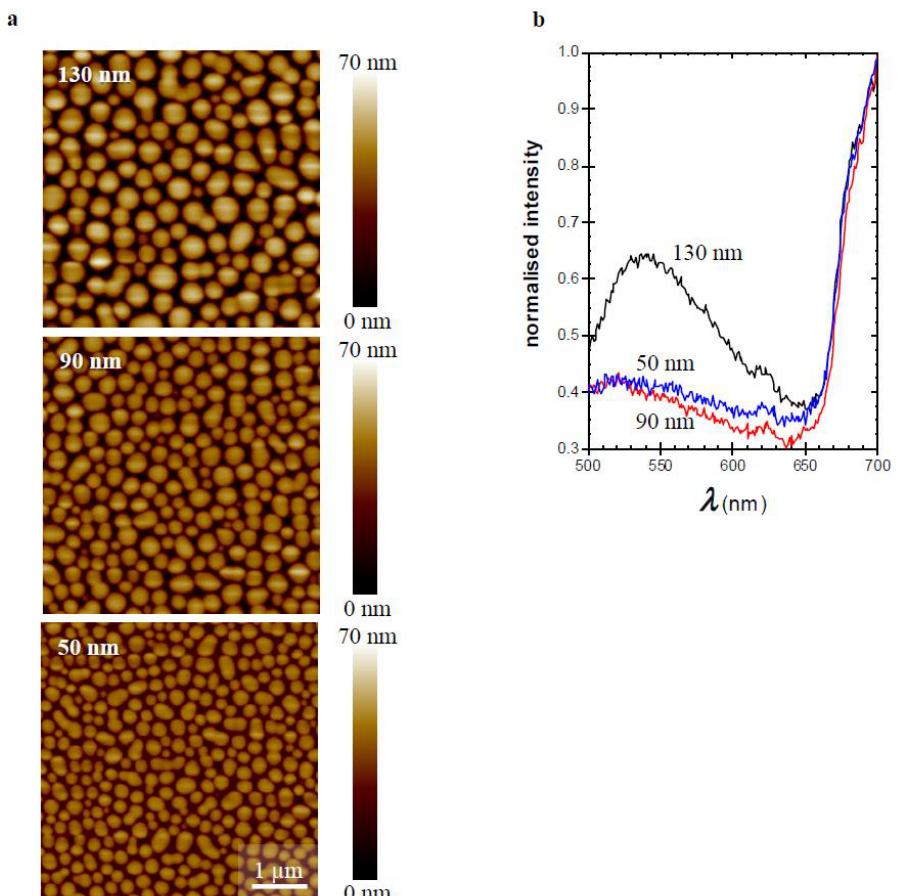
Figure 4. ( a ) AFM micrographs (5 × 5 µ m) of thin films of 1:3 TQ1:PC 70 BM spin-coated from CB with the indicated film thicknesses. A height scale is added to each image. ( b ) Corresponding fluorescence emission spectra for films with indicated